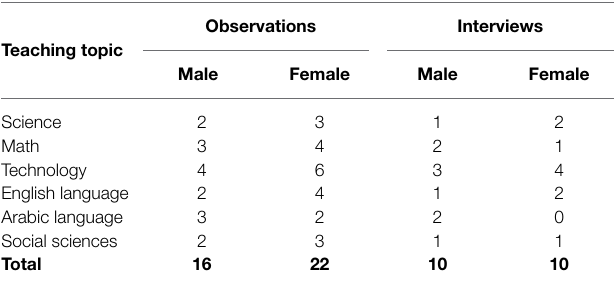
TABLE 1 | Teaching area and gender of the participants in the